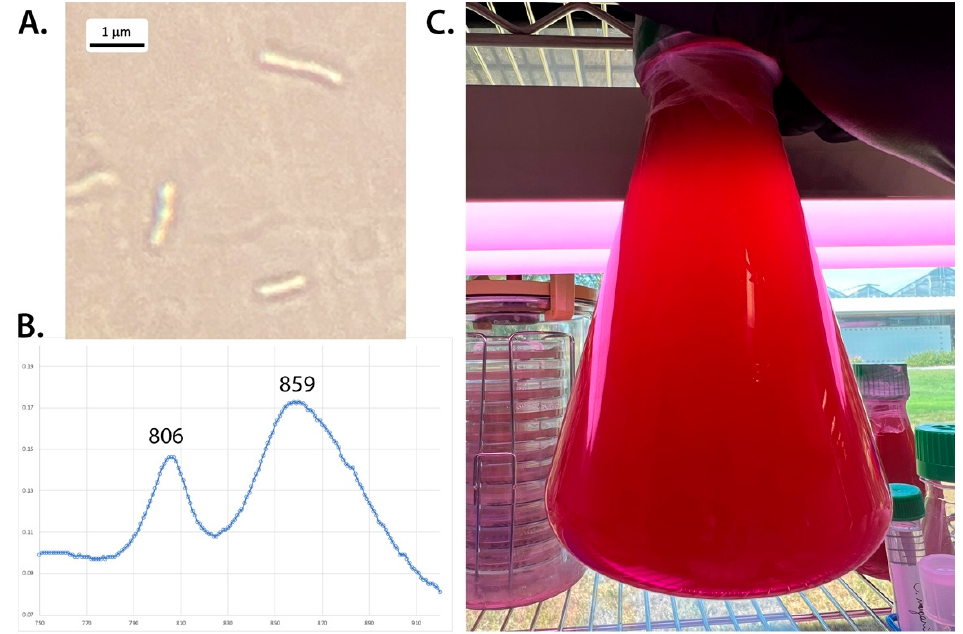
Figure 1. ( A ) Microscopy of Rhodopseudomonas strain HC1 at 1000 × total magnification. ( B ) Absorp- tion spectra of from whole cells of Rhodopseudomonas HC1 shows near IR absorption characteristic of BChl a . ( C ) Cultures of Rhodopseudomonas HC1 show a distinctive red color.